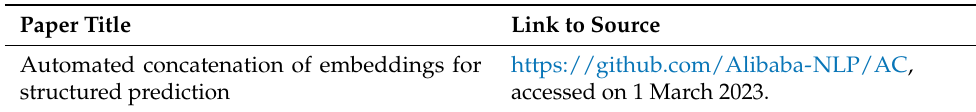
Table 8. Source code links for Named Entity